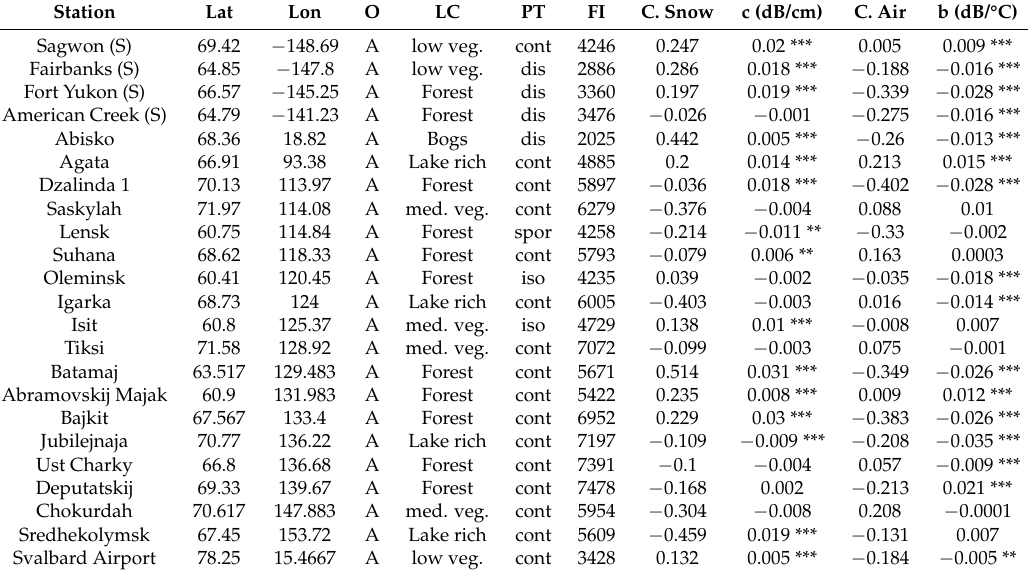
Table 1. SNOTEL (S) and WMO stations, Orbits (O) for ASCAT measurements (A, Ascending; D, Descending; and B, average from both), Landcover (LC), Permafrst type (PT), long–term average freezing index in degree–days (FI), results for pearson correlation for snow depth (C. snow) and air temperature (C. air), estimated parameters for snow depth (c) and air temperature (b) with significance